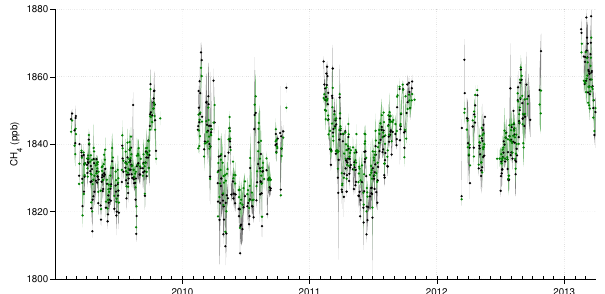
Figure 7. Daily median tropospheric column-averaged DMFs at So- dankylä using the Washenfelder et al. (2003) method (black) vs. the updated method (green). Tropospheric column DMFs are the same as in Fig.